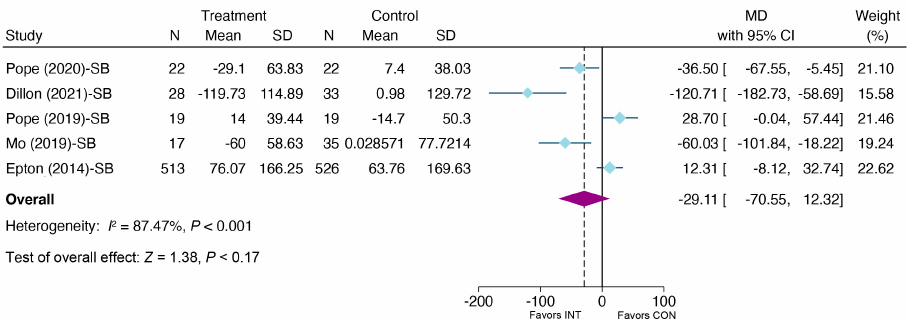
Figure 6. Meta-analysis of effects of e-health interventions on SB versus control [37,48–50,58].